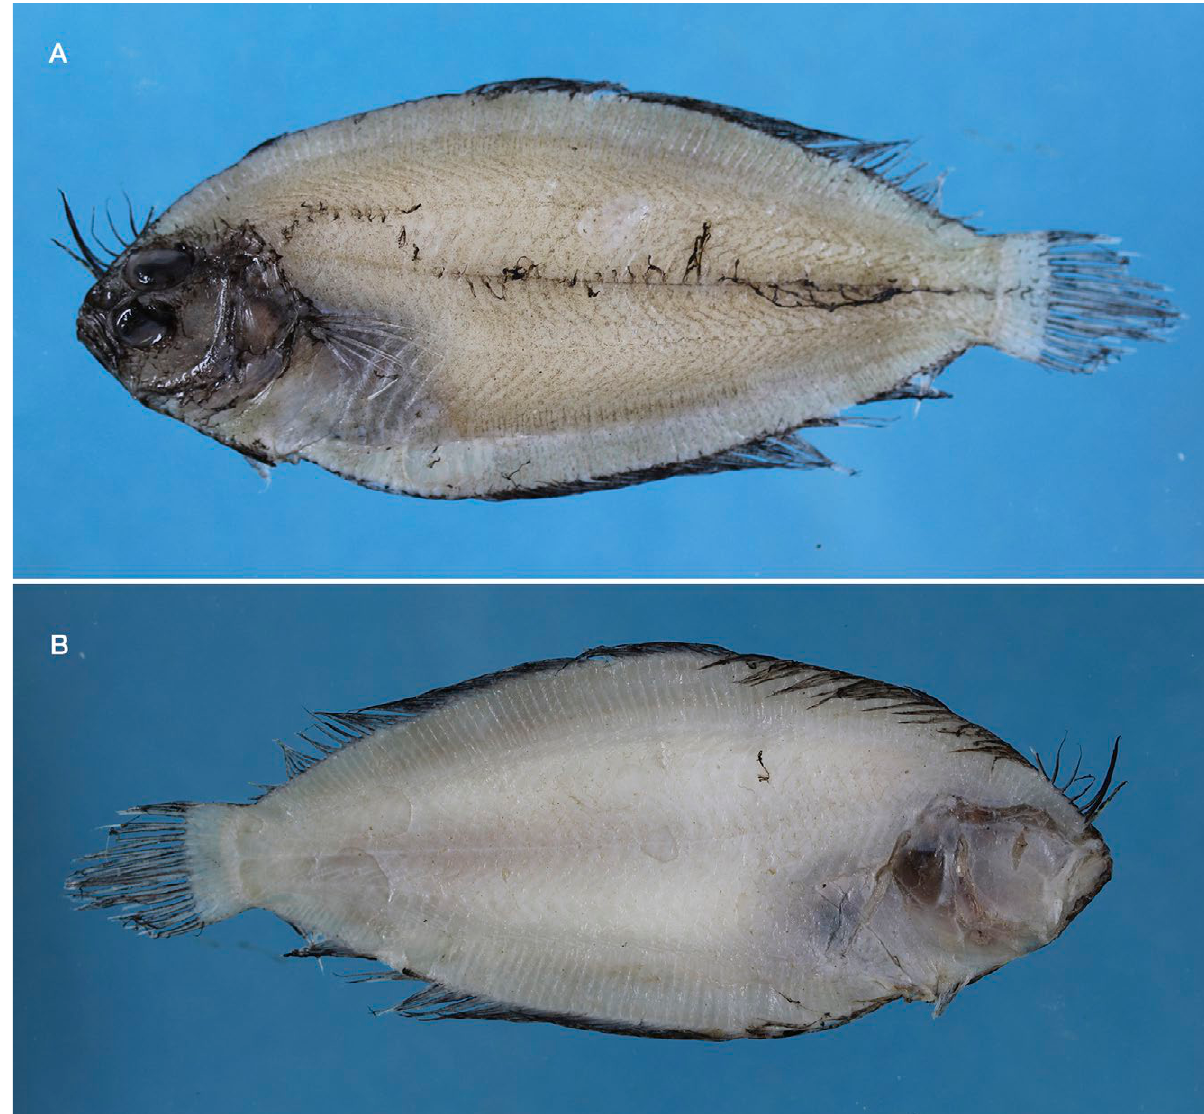
Fig. 1. – Arnoglossus nigrofilamentosus n. sp., HUJ 20663, holotype, 96.6 mm SL, Jaffa, Israel. A, ocular side; B, blind side. Photographs by D.